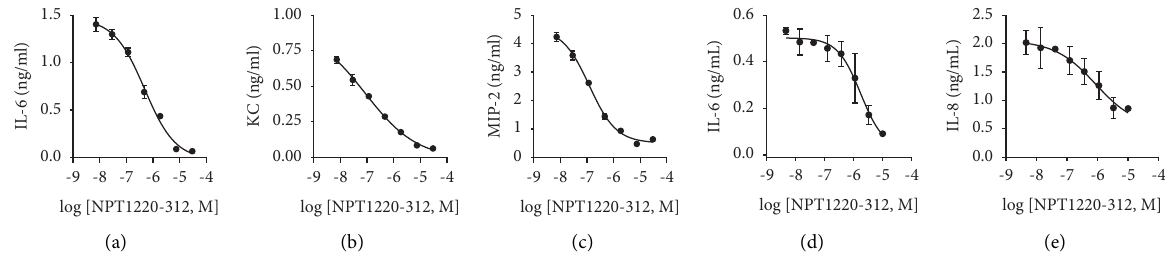
Figure 6: NPT1220-312 blocks Pam 3 CSK 4 -evoked cytokine release in whole blood. NPT1220-312 blocked: (a) Pam 3 CSK 4 -evoked release of: IL-6; (b) murine IL-8 homologues: KC; and (c) MIP-2 in murine whole blood. NPT1220-312 blocked: (d) Pam 3 CSK 4 -evoked release of: IL-6 and (e) IL-8 in human whole